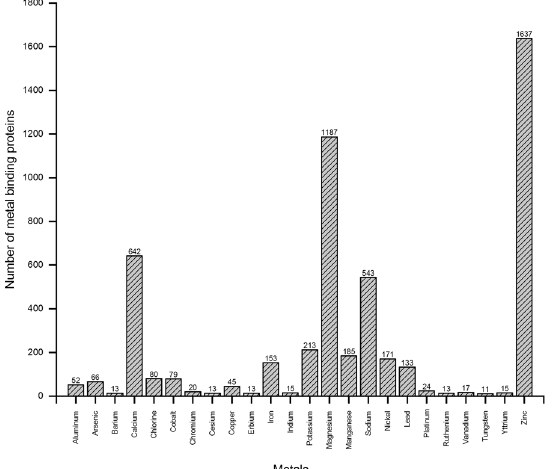
Fig. 2 The Bar diagram indicating the number of metal-bounded proteins collected for each metal from the protein database.